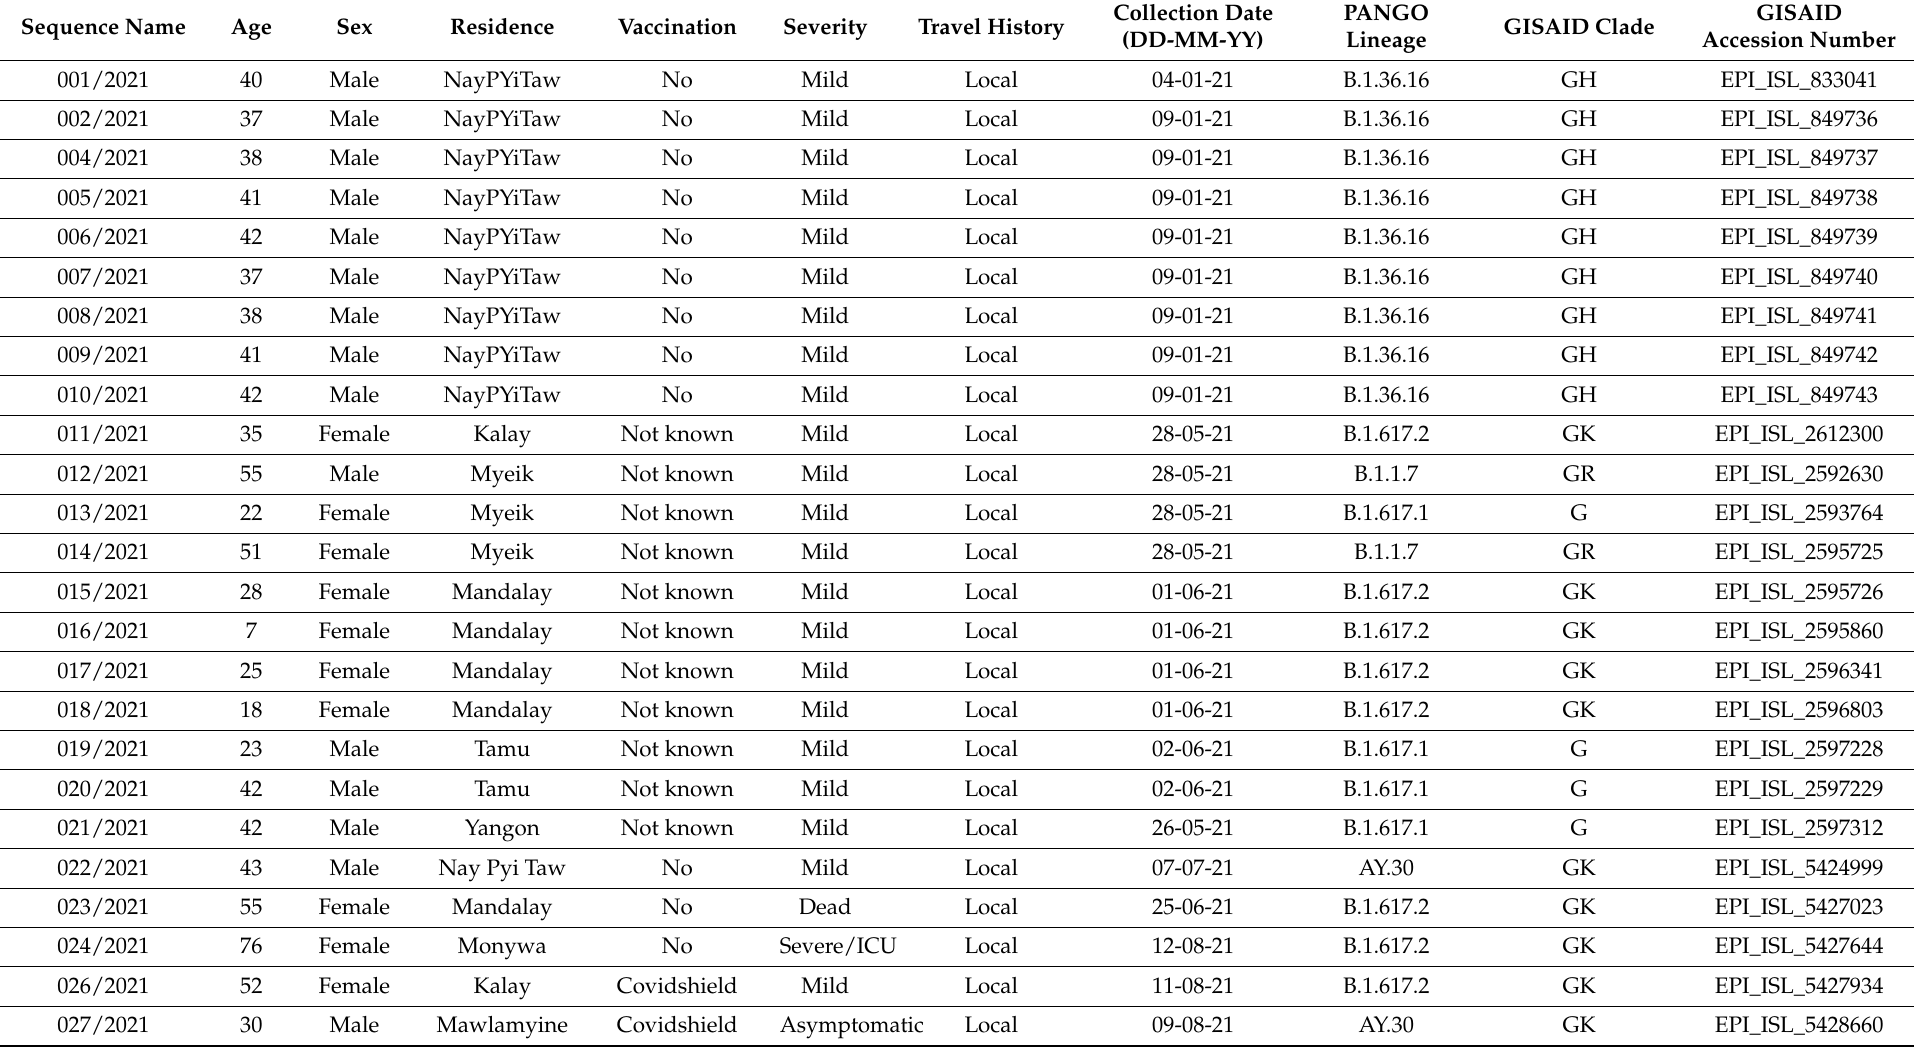
Table 1. Genotyping of Myanmar SARS-CoV-2 sequences with demographic